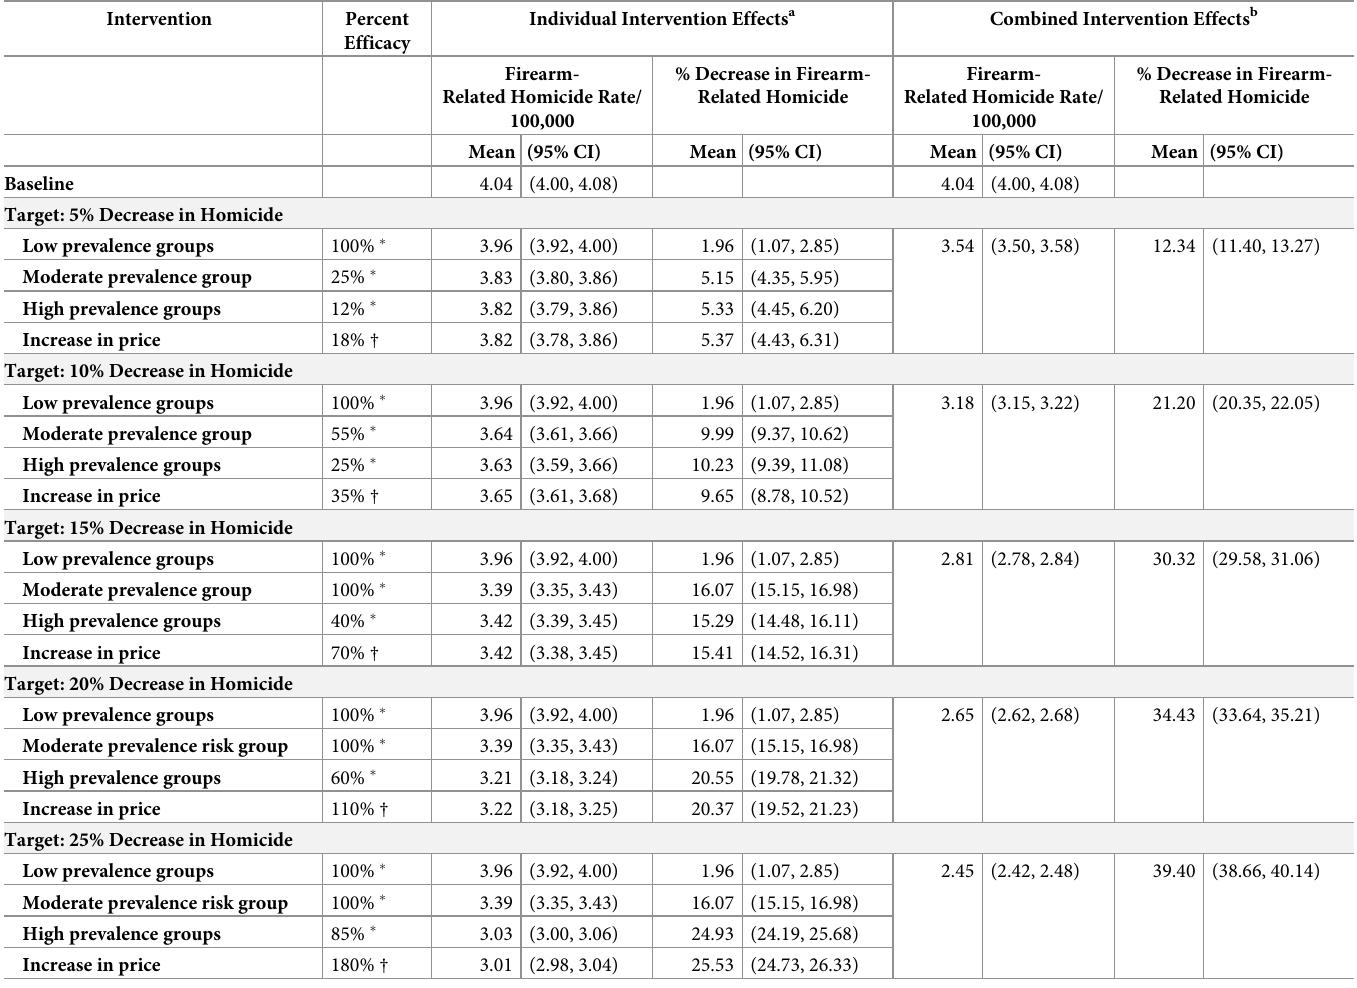
Table 2. Simulation of gun-related homicide in New York City after implementing firearm disqualification and price increases with a 1% price elasticity.